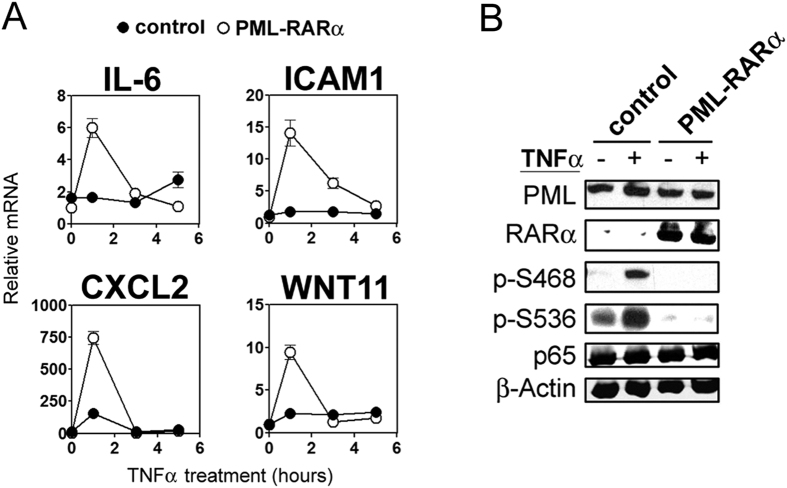
PML-RARα supresses NF-κB activity.WT MEFs were transfected with empty vector (control) or PML-RARα plasmid and were (A) treated with TNFα (10 ng/ml) for the indicated time prior to QPCR analysis for IL-6, ICAM1, CXCL2 and WNT11; (B) treated with TNFα (10 ng/ml) for 10 minutes prior to analysis by immunoblotting with the indicated antibodies.